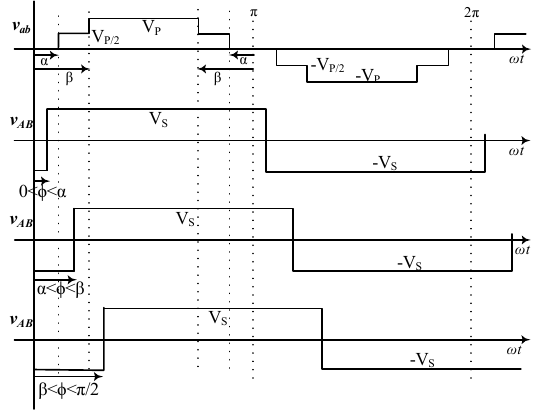
Figure 5. Voltage waveforms in a 5L-2L DAB for three different cases of buck topology